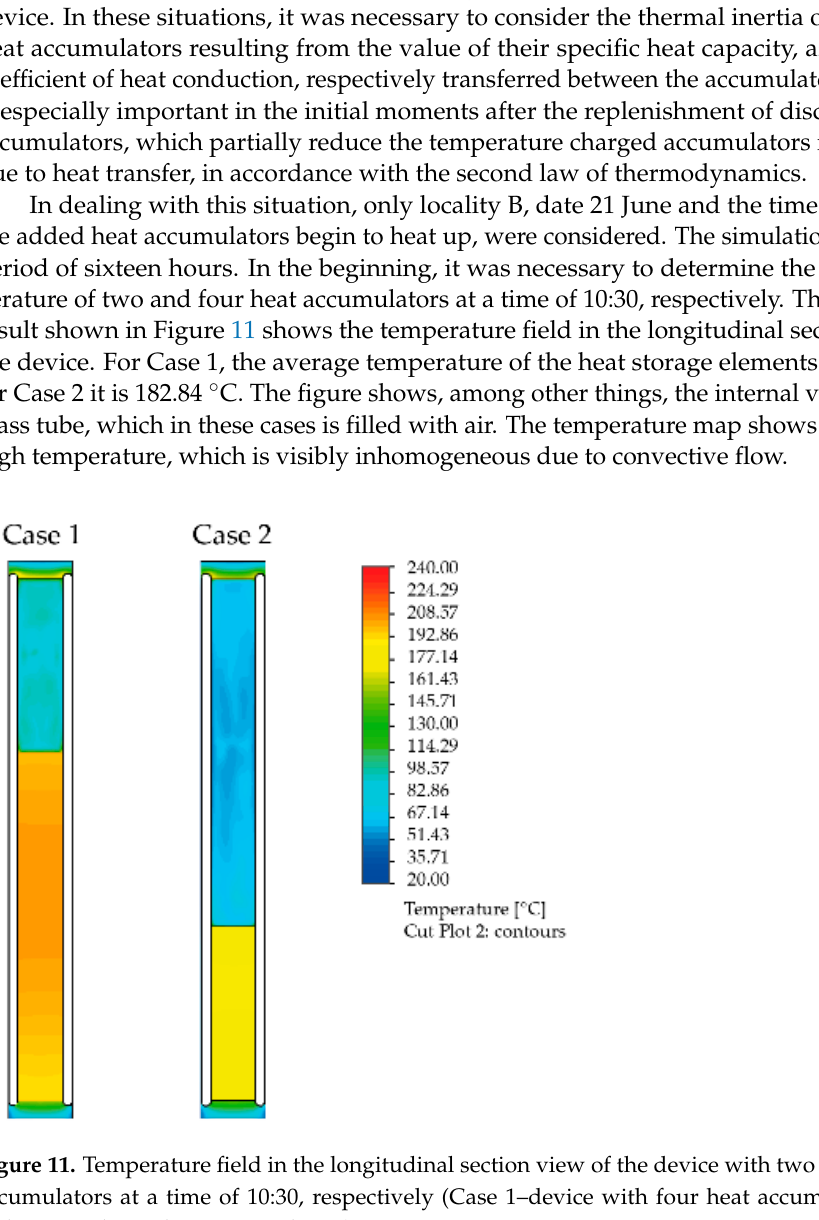
Figure 11. Temperature field in the longitudinal section view of the device with two and four heat accumulators at a time of 10:30, respectively (Case 1–device with four heat accumulators, Case 2–device with two heat accumulators).